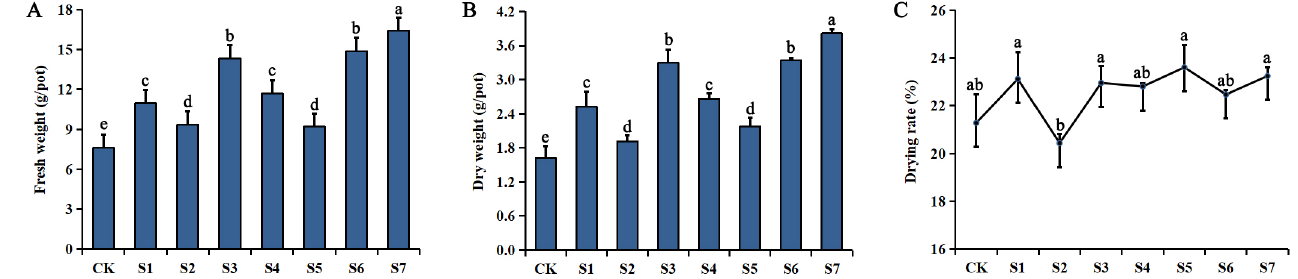
Figure 1. Effects of inoculation with organophosphate-degrading bacteria (OPDB) on the fresh weight ( A ), dry weight ( B ), and drying rate ( C ) of rhizomes of Paris polyphylla var. yunnanensis . Data (means ± SD, n = 3) followed by different letters above the bars indicate significant ( p < 0.05) differences between treatments. Note: S1–S7 stand for Sample 1–Sample 7.